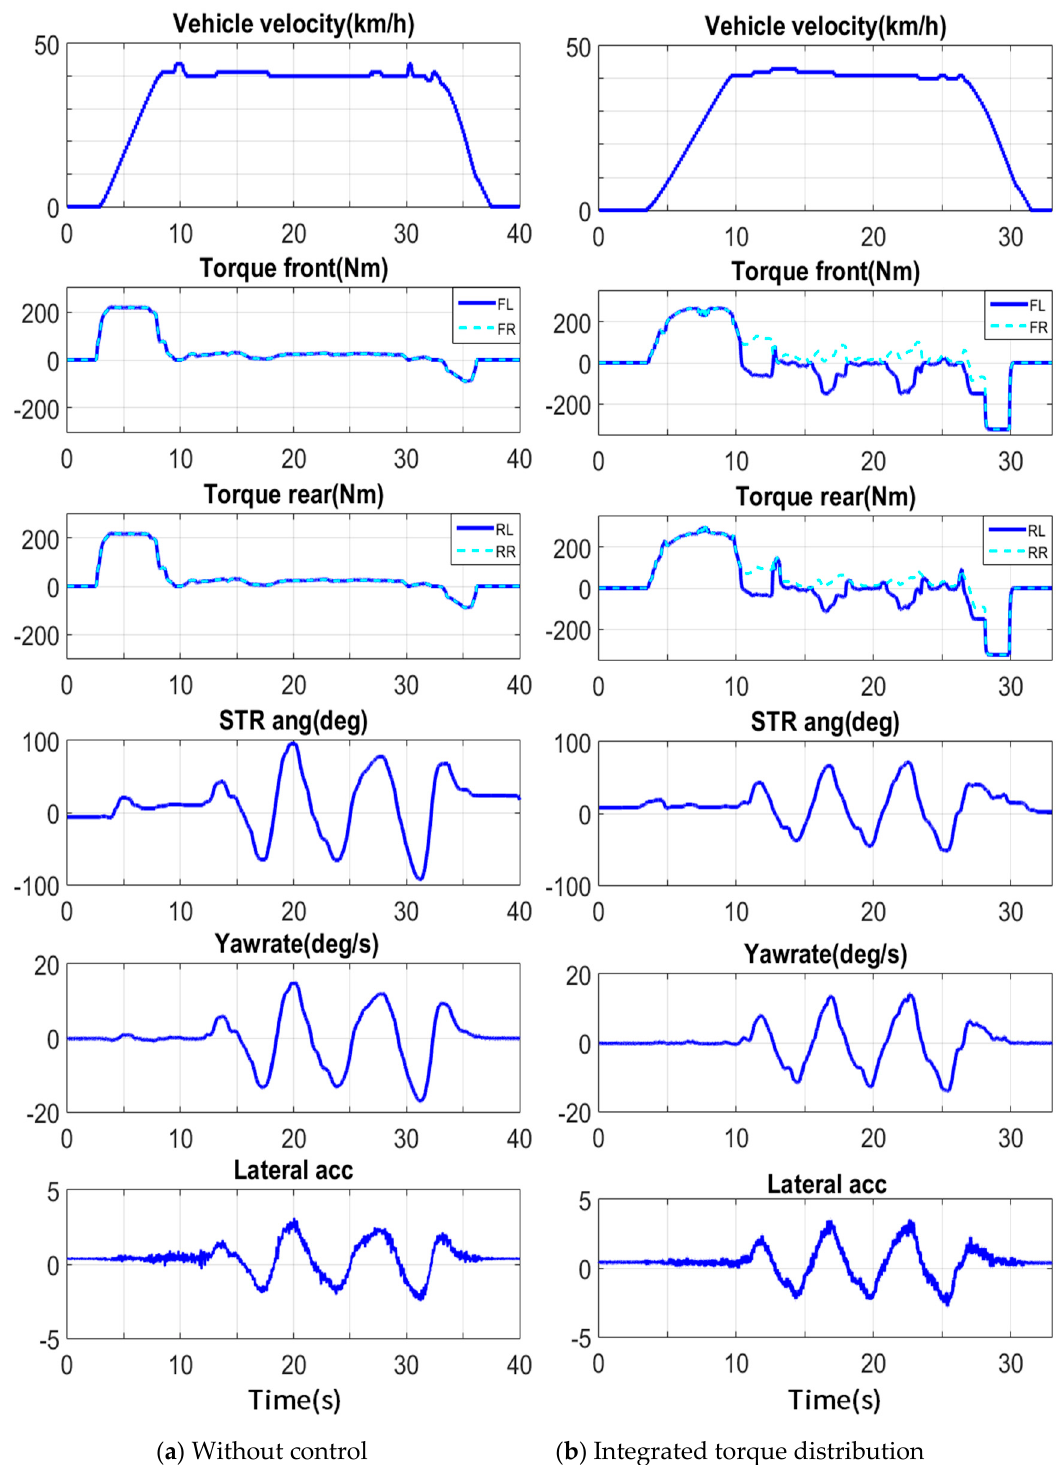
Figure 18. Slalom test results (Target velocity: 40 km/h). Table 3. Peak values of slalom test results.